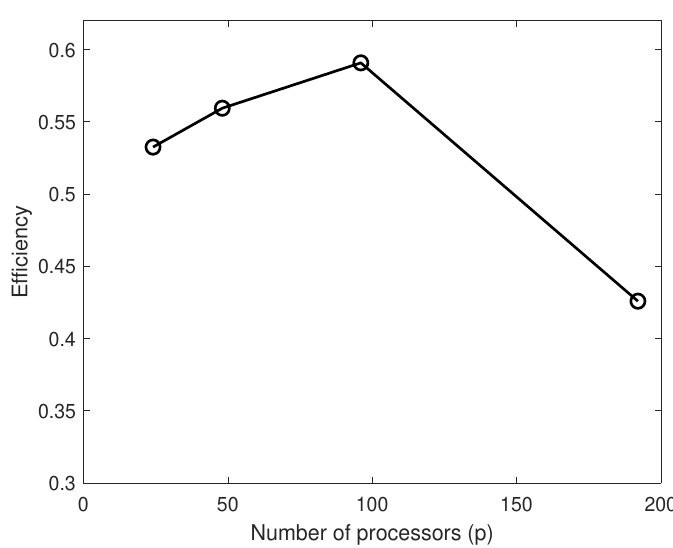
Figure 16. Variation of efficiency ( η ) with increase in number of processors ( p